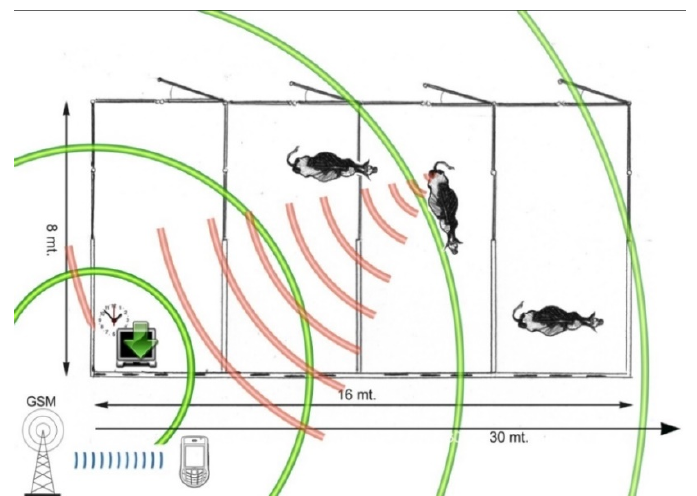
Figure 4. Schematic illustration of the remote calving alarm system. The Central Unit is able to simultaneously manage up to six intravaginal probes and should be placed within 30 m from gestating cows. At the beginning of stage II of labor the probe is expelled from the vaginal canal, leading to the activation of the radio signal, which is decoded by the Central Unit. The cell phone Sim Card within the Central Unit uses the GSM connection to send the alert to the user contacts recorded in the internal memory.